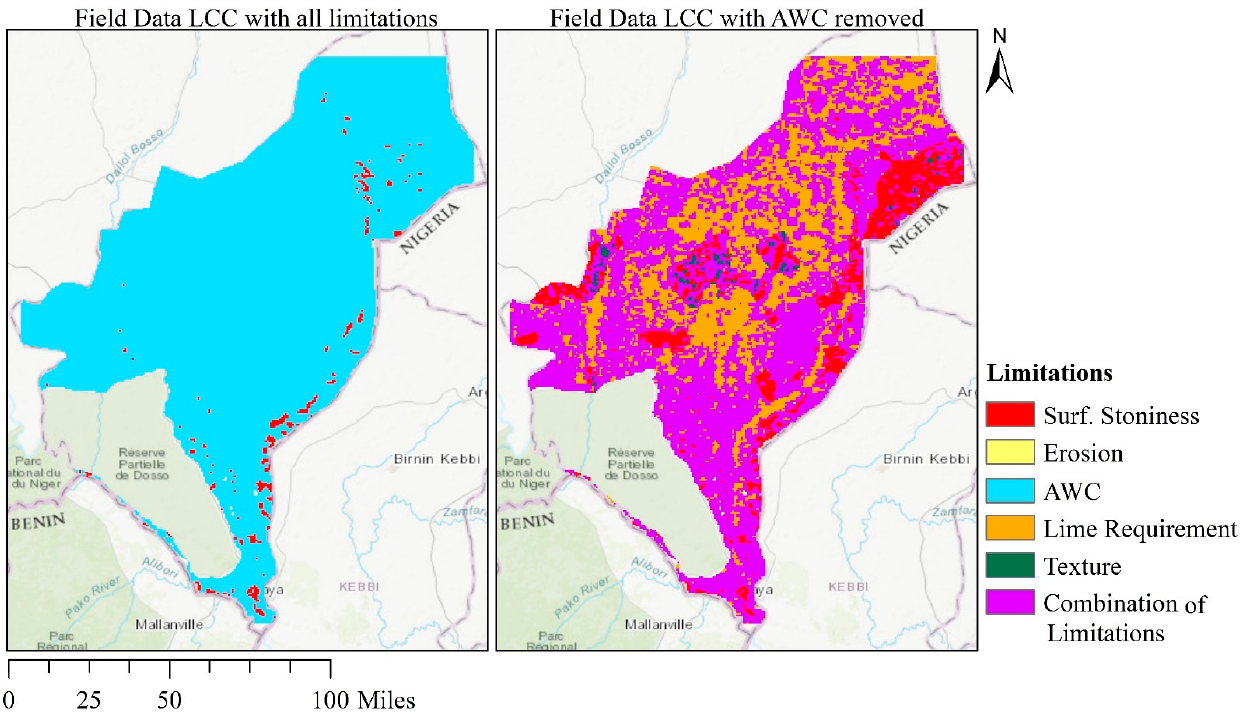
Figure 4. Field Data LCC limitations with and without AWC as a limitation.